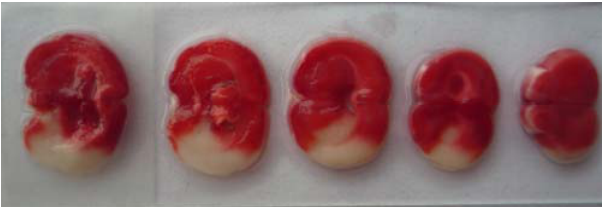
Figure 1. The cerebral infarction volume. The normal brain tissues showed red and infarct tissue white by TTC staining.